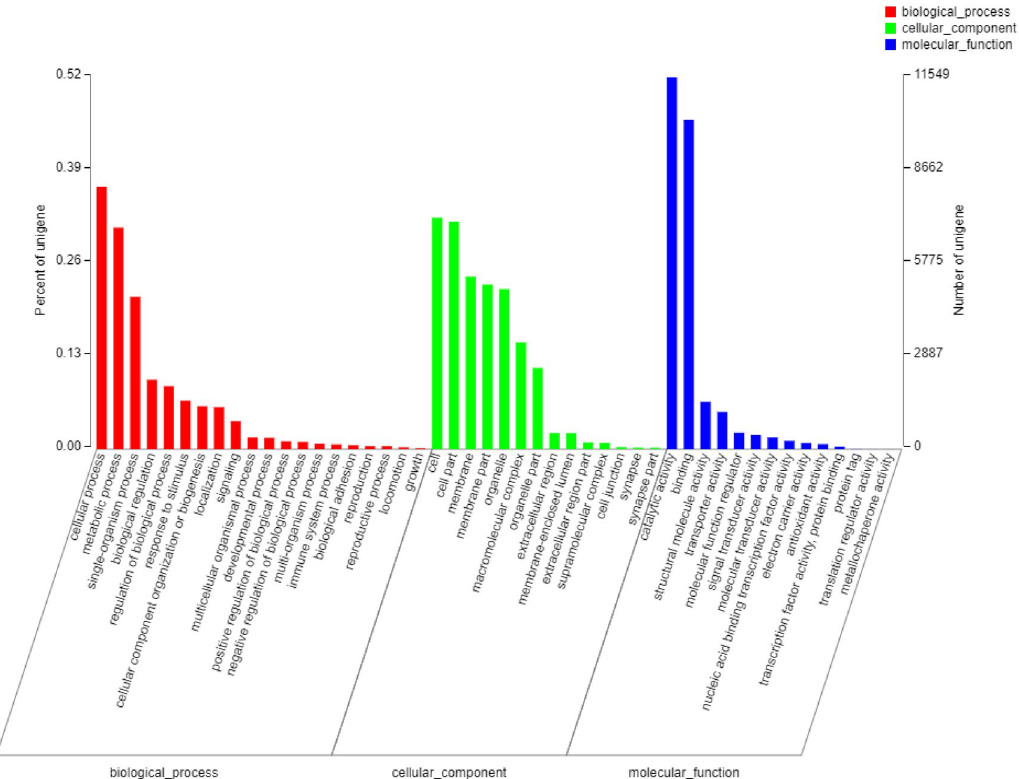
Figure 4. GO functional annotation of adult female spongy moth transcriptomes.